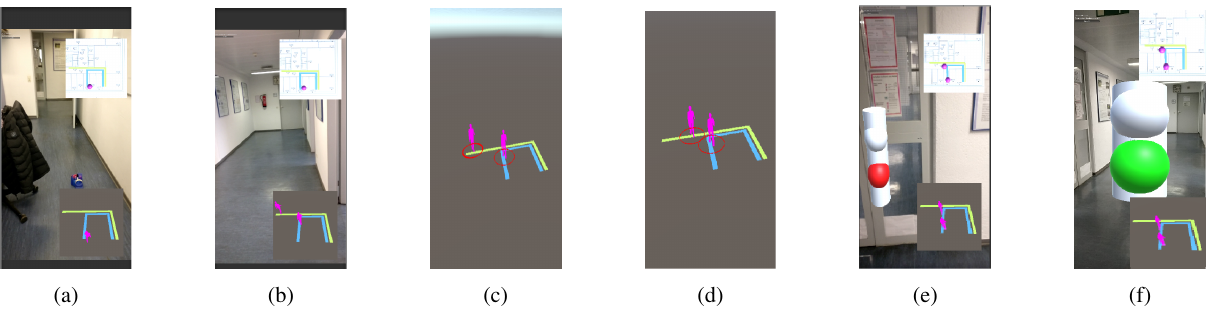
Figure 5: (a) Low priority participant P1 as he starts navigation (b) high priority participant P2 starts to walk independently to his destination (c) P1 and P2 as visualized in virtual world with radial vicinity check (d) P1 and P2 initiating control actions as an interaction is identified (e) P1 is signalled to stop (f) P2 signaled to continue motion.